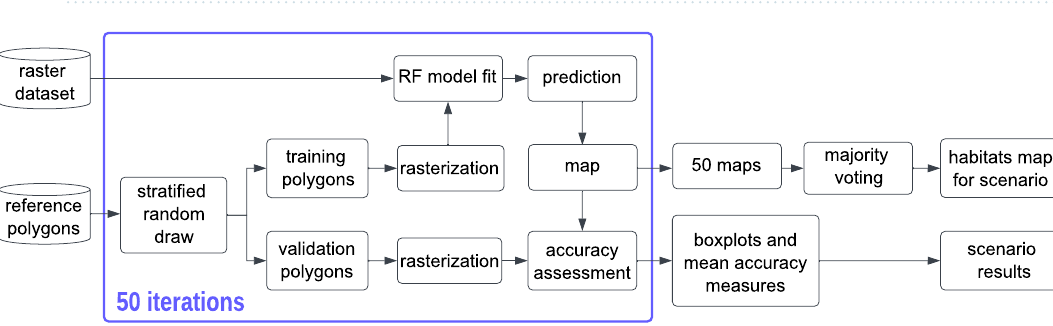
Figure 3. The procedure comparing HS and S2 data. Figure created by the authors using Inkscape (https:// inksc ape. org).